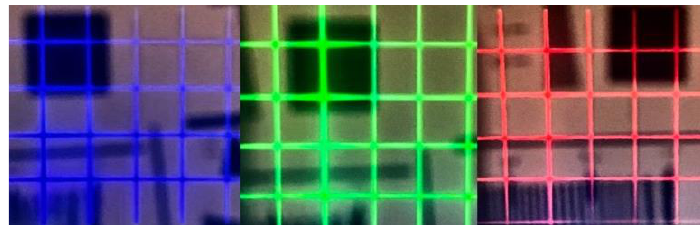
Figure 12. An image observed using a holographic waveguide.